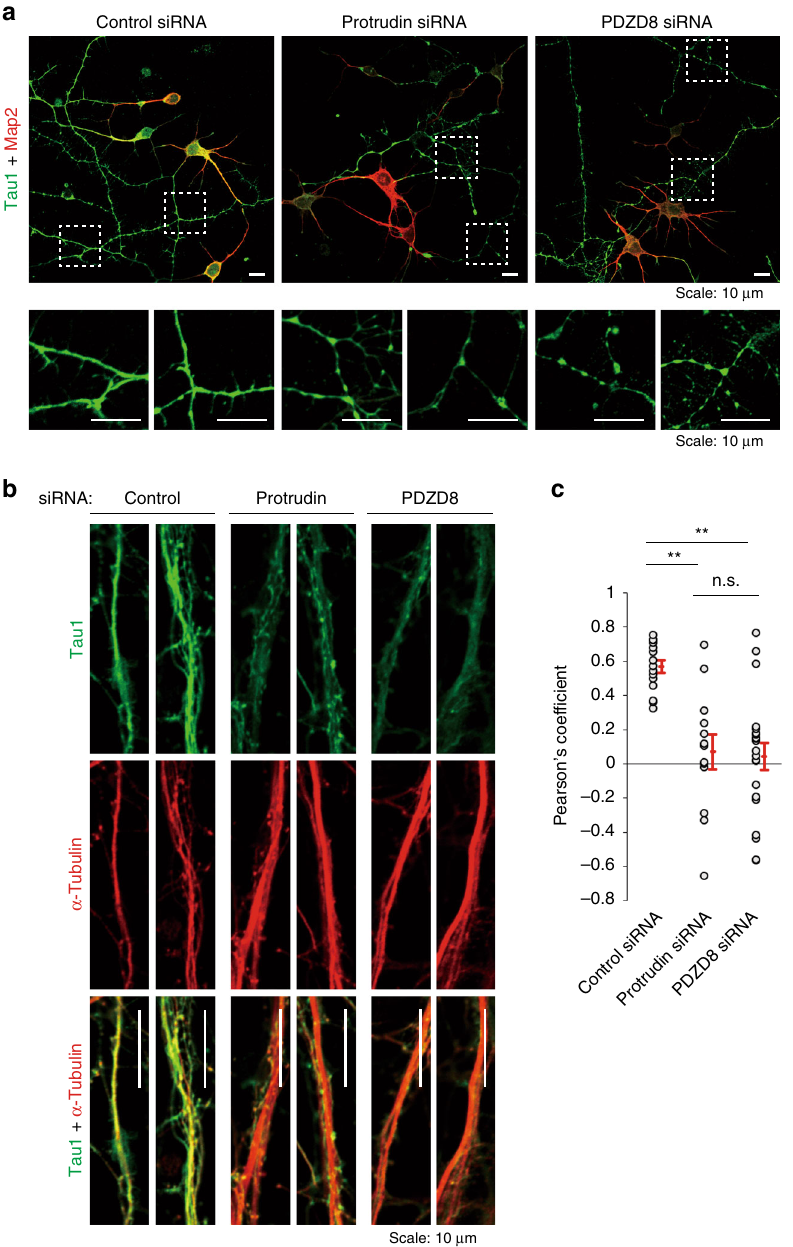
Fig. 9 Effects of protrudin and PDZD8 on neuronal integrity. a Mouse primary cortical neurons transfected with control, protrudin, or PDZD8 siRNAs were cultured for 4 days in vitro, fi xed, stained with antibodies to Tau1 and to Map2, and observed with a confocal fl uorescence microscope. Scale bars, 10 µ m. The boxed regions of the upper panels are shown enlarged below. Scale bars, 10 µ m. b Neurons transfected as in a were cultured for 7 days in vitro, fi xed, stained with antibodies to Tau1 and to α -tubulin, and observed with a confocal fl uorescence microscope. Enlarged images of axons are shown. Scale bars, 10 µ m. c Pearson ’ s colocalization coef fi cient for Tau1 and α -tubulin in images as in b . Data are means + SE for 13 to 21 independent regions. ** P < 0.01 (Kruskal – Wallis test followed by the Steel-Dwass multiple comparison test). We repeated all experiments at least three times independently with similar RNAiMAX (Invitrogen Life Technologies), and rat and mouse siRNAs were intro- duced into PC12 cells and mouse primary neurons, respectively, with the use of a Nucleofector instrument (Lonza). The cells were then cultured for 72h. Total RNA was isolated from cells with the use of an RNeasy Kit (Qiagen, Hilden, Germany) and was subjected to reverse transcription (RT) with the use of a QuantiTect Rev Transcription Kit (Qiagen). The resulting cDNA was subjected to real-time PCR analysis with Power SYBR Green PCR Master Mix in an ABI-Prism 7000 sequence detection system (Applied Biosystems, Foster City, CA). The amounts of each target mRNA were calculated and normalized by that of GAPDH mRNA as described previously. Primers for PCR are shown in Supplementary Table 2.